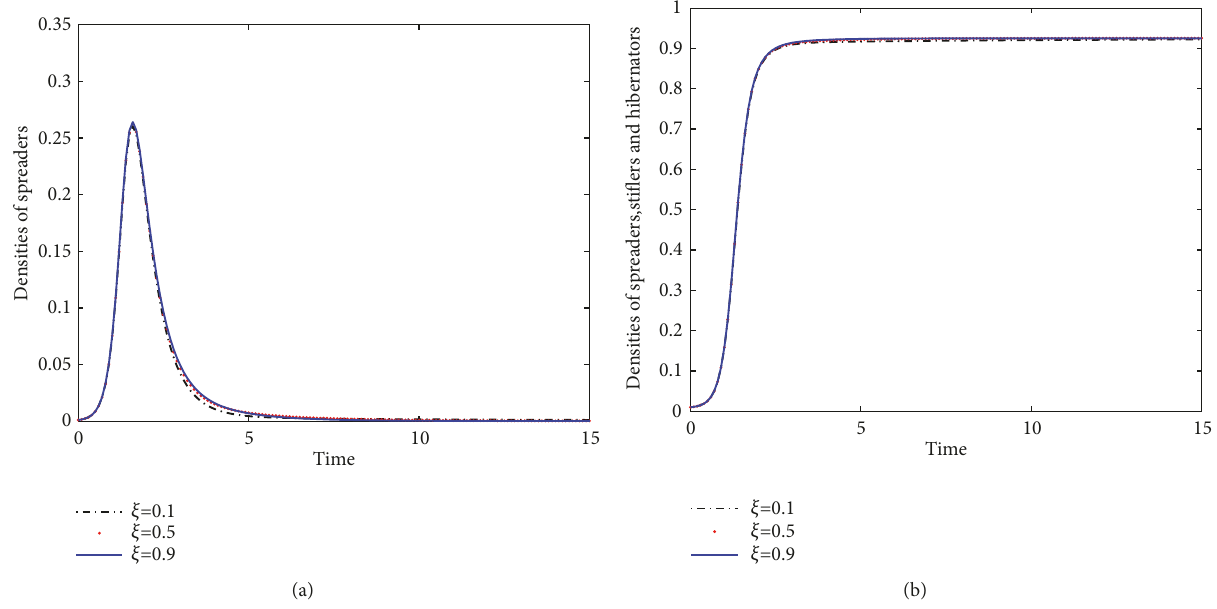
Figure 10: Numerical simulations of (3) with 𝜆 = 0.7 , 𝛽 = 0.3 , 𝛼 = 0.2 , 𝛿 = 0.2 , and 𝜂 = 0.2 and different 𝜉 in the network with the Poisson degree distribution. (a) The trajectories of the densities of spreaders. (b) The trajectories of the densities of spreaders, stiflers, and hibernators.